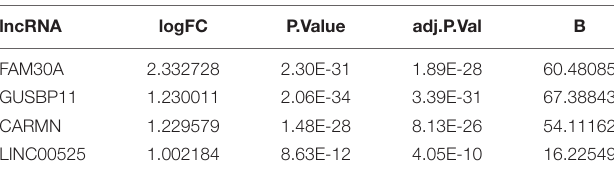
TABLE 1 | Differential expression of lncRNAs between periodontitis and healthy gingival